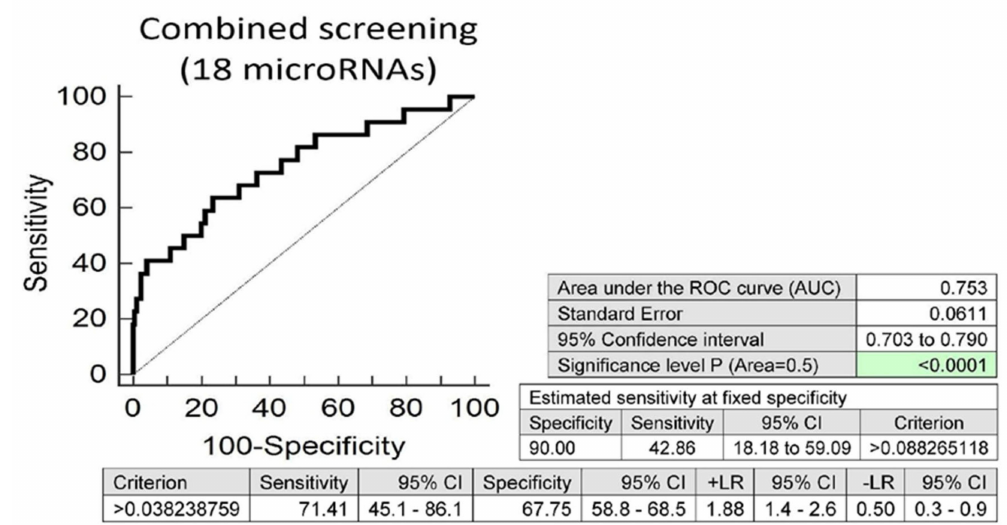
Figure 5. Aberrant microRNA expression profile in overweight / obese children descending from complicated pregnancies. Combined screening revealed that at 10.0% FPR, 42.86% of overweight / obese children had a substantially altered microRNA expression profile (miR-1-3p, miR-16-5p, miR-17-5p, miR-20a-5p, miR-26a-5p, miR-92a-3p, miR-103a-3p, miR-125b-5p, miR-126-3p, miR-130b-3p, miR-133a-3p, miR-146a-5p, miR-181a-5p, miR-195-5p, miR-199a-5p, miR-210-3p, miR-221-3p and